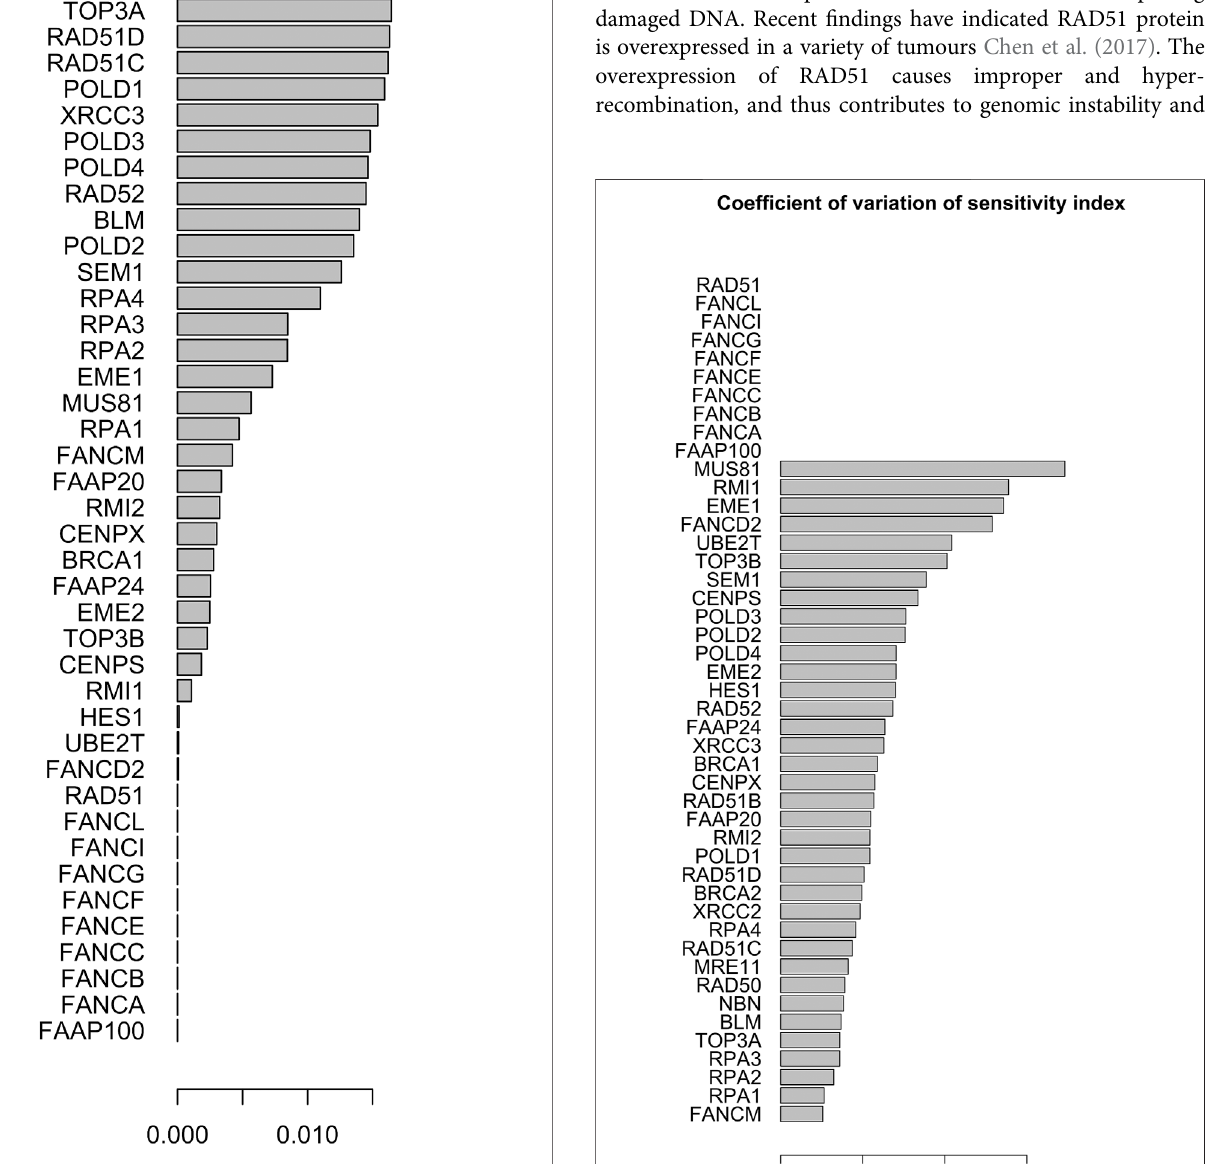
FIGURE 10 | Mean of the sensitivity index distributions for the proteins in HR network Orlic-Milacic, (2015) merged with FANCM pathway (Pathways Commons, 2022). These results refer to simulation in the time interval [0, 1400] a.u., and initial values of the proteins randomly sampled in the range [18, 20] a. u. and kinetics rate values sample in [10 – 5 , 10 – 6 ] a. u.